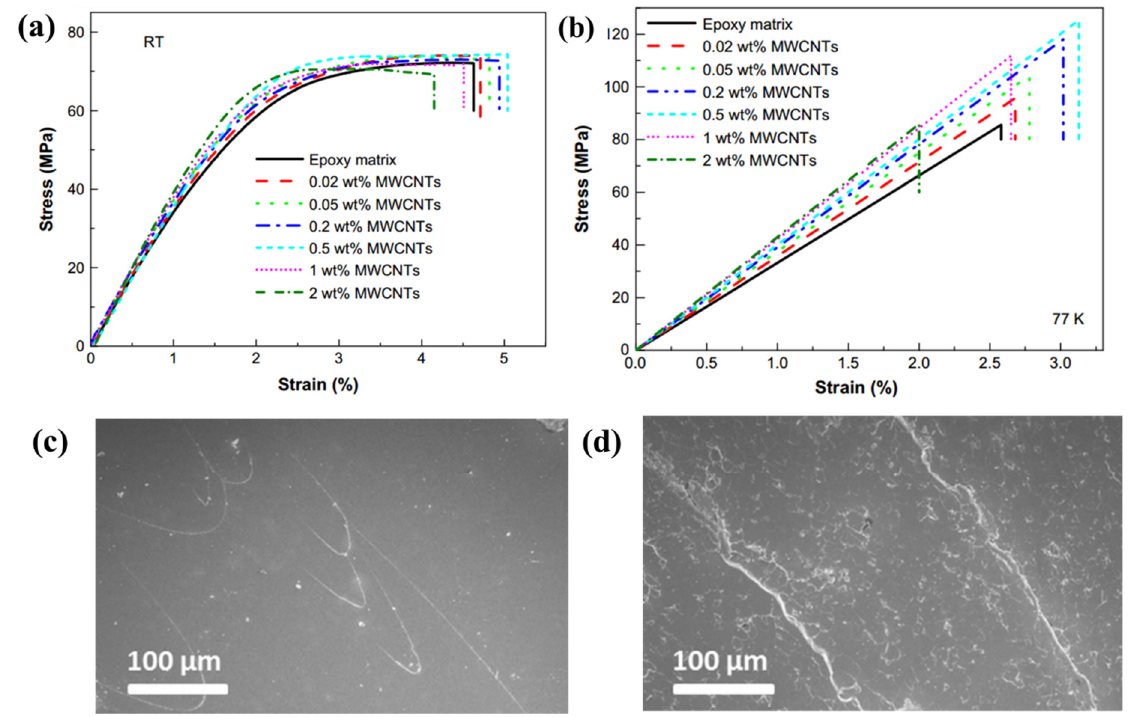
Figure 4. The stress-strain curves of MWCNT/epoxy nanocomposites ( a ) at room temperature and ( b ) at 77 K. Reused with permission from Ref. [37]. Copyright 2009 Elsevier. The SEM images of impact fracture surfaces at 77 K of ( c ) epoxy and ( d ) 0.5 wt CNTs modified epoxy. Reused with permission from Ref. [39]. Copyright 2013 Elsevier.